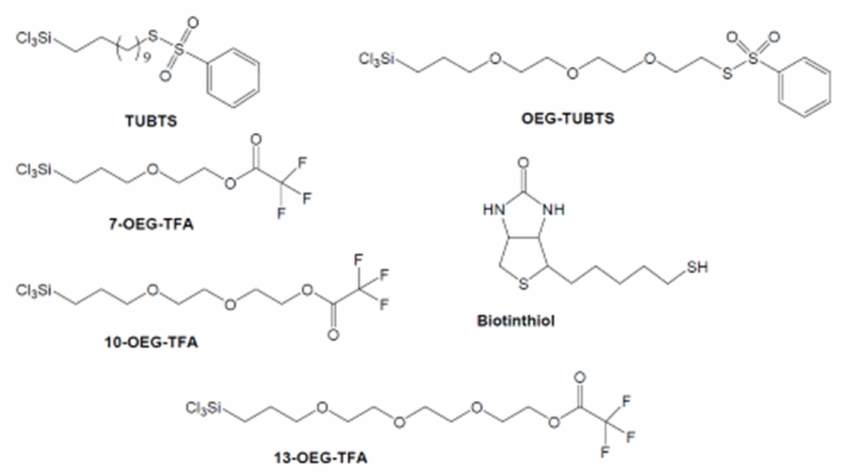
Figure 2. Structures of S–(11–trichlorosilyl-undecenyl) benzenethiosulfonate (TUBTS),